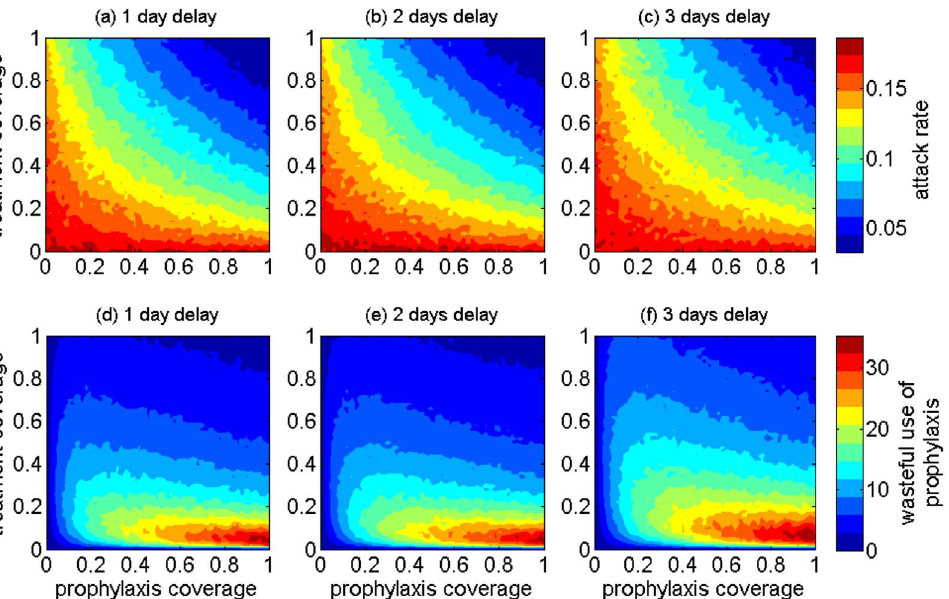
Figure 4. The projected effect of combining antiviral treatment of infectious cases with prophylaxis of their close contacts on population attack rates (a–c) and wasteful use of drugs (d–f) in the SD demographics when antiviral treatment delays range from